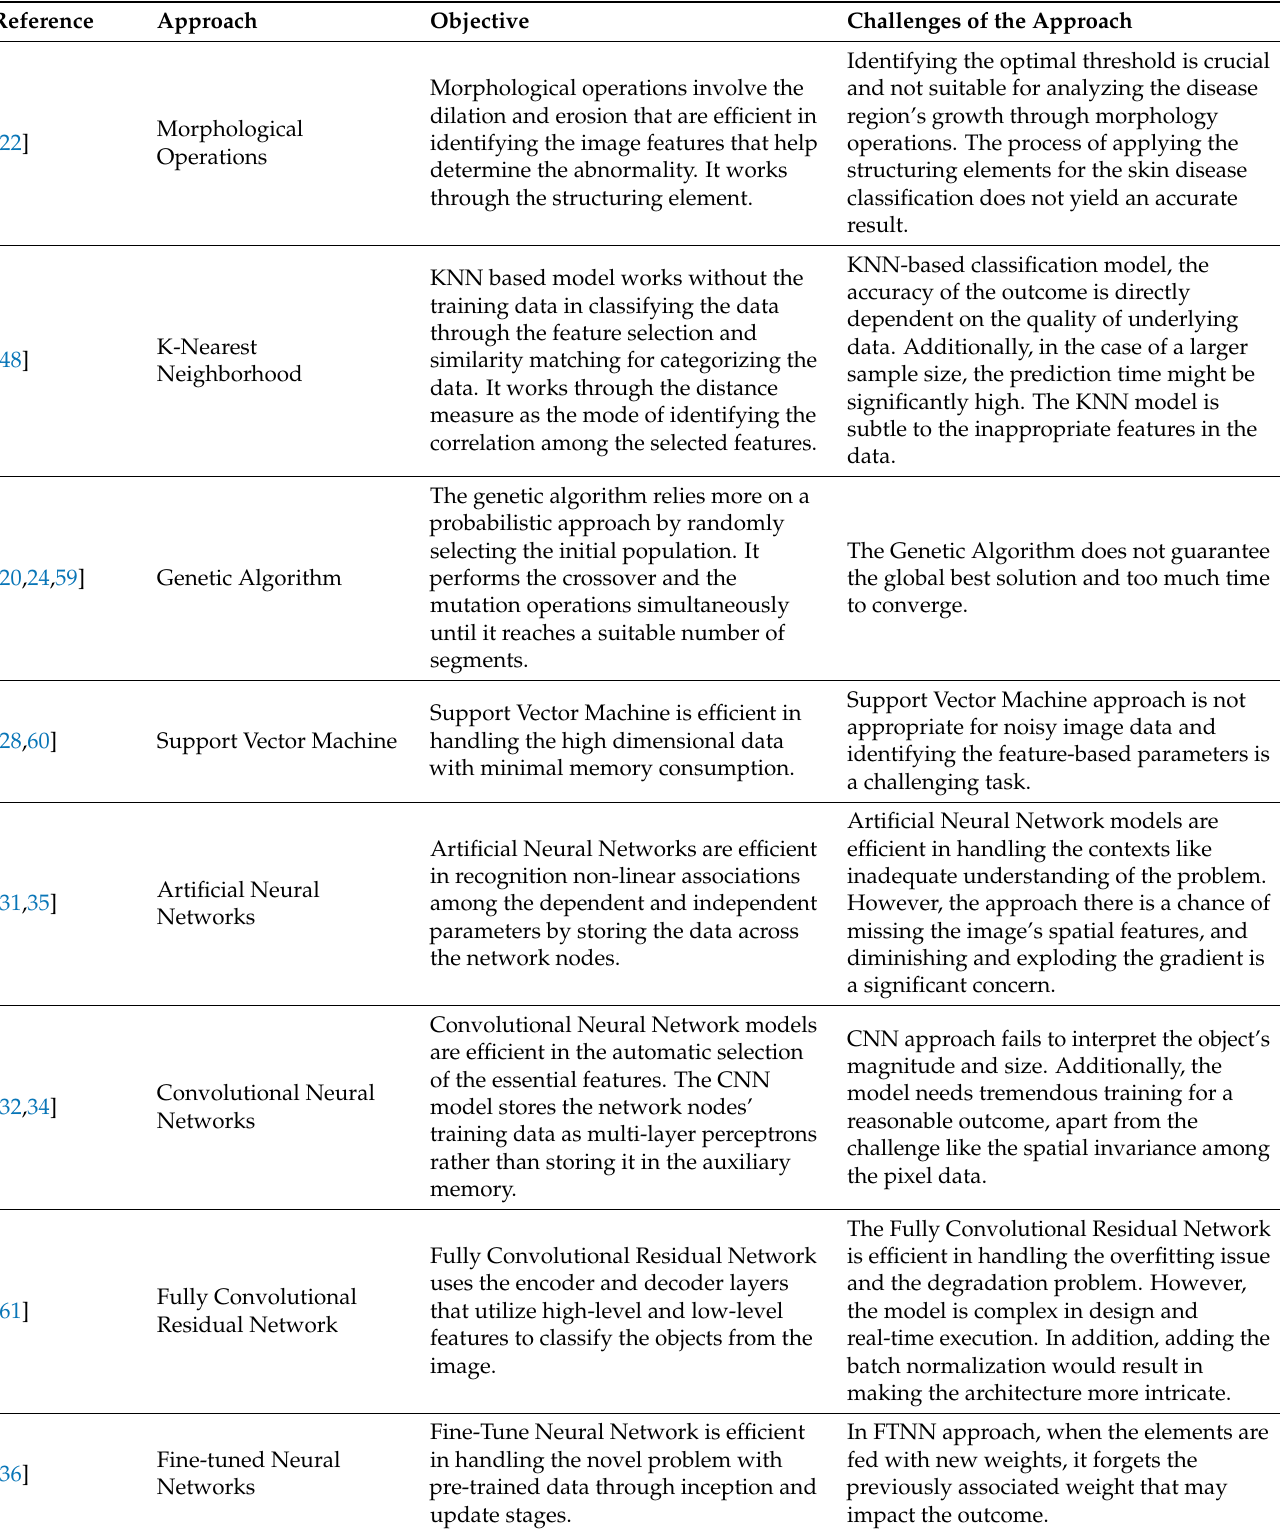
Table 1. The related work of the machine and deep learning approaches for image